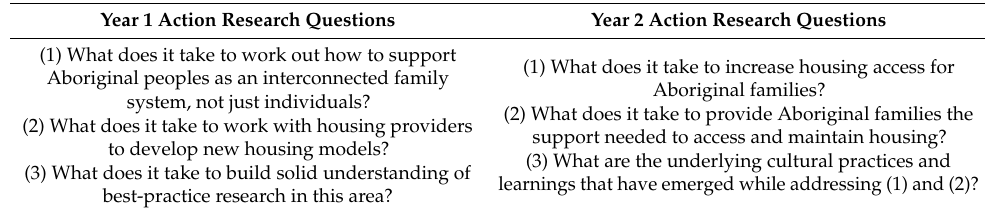
Table 3. Yearly research action